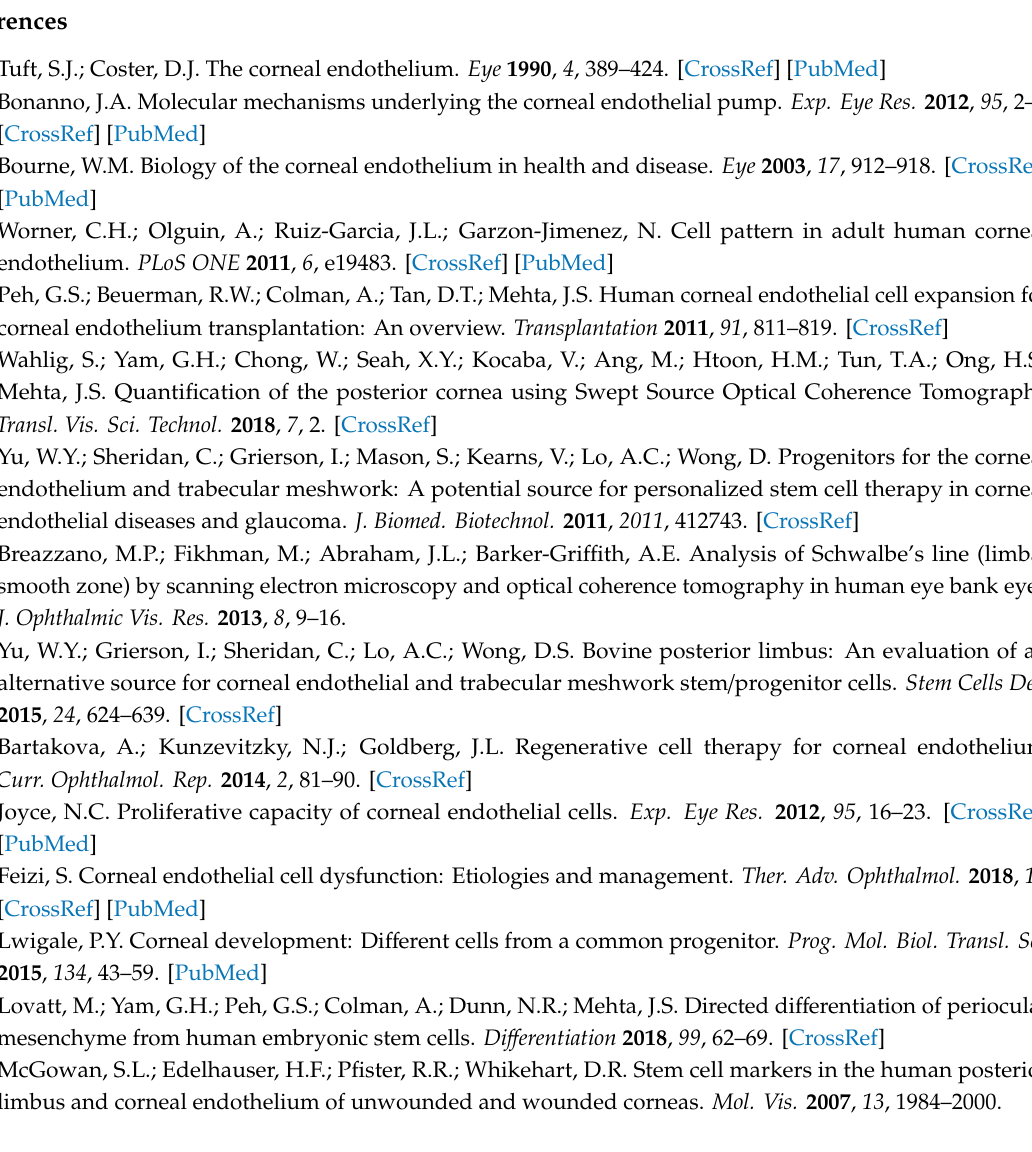
information, Table S3: Expression primers, Video S1: Serial block face-scanning electron microscopy (SBF-SEM) and 3D reconstruction of human transition zone / peripheral endothelium (TZ / PE) junction, Video S2: Serial block face-scanning electron microscopy (SBF-SEM) and 3D reconstruction of human transition zone / peripheral endothelium (TZ / PE) junction. Available online at https: // zenodo.org / record /